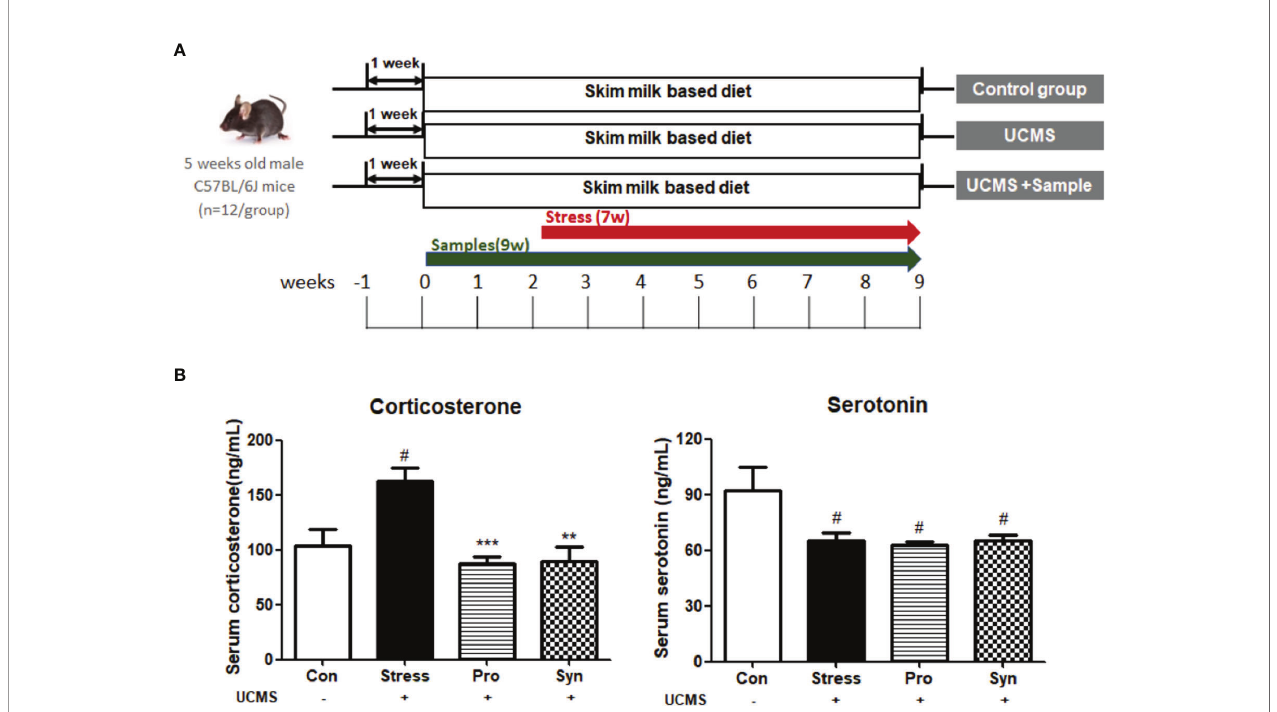
FIGURE 1 | (A) Schematic overview of the animal experiments. (B) Effects of probiotics and synbiotics treatment on the serum concentrations of corticosterone and serotonin in mice during UCMS. Data are expressed as the mean ± SEM (n=12) from three independent experiments. # Signi fi cant difference when compared to